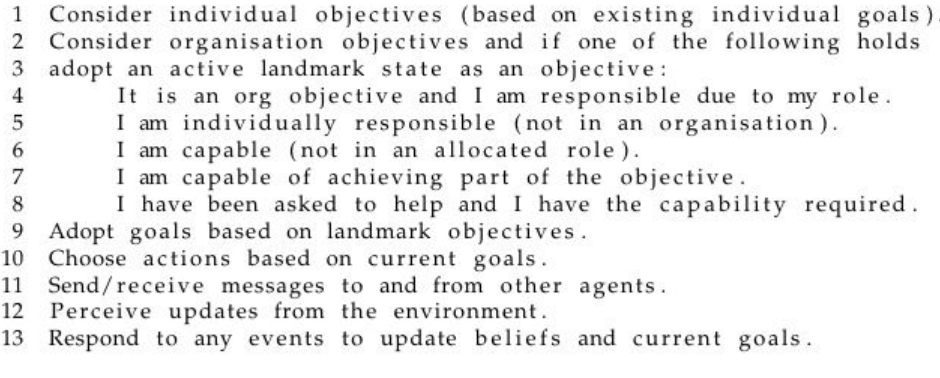
Figure 2. Reasoning cycle of organisation-aware agents.